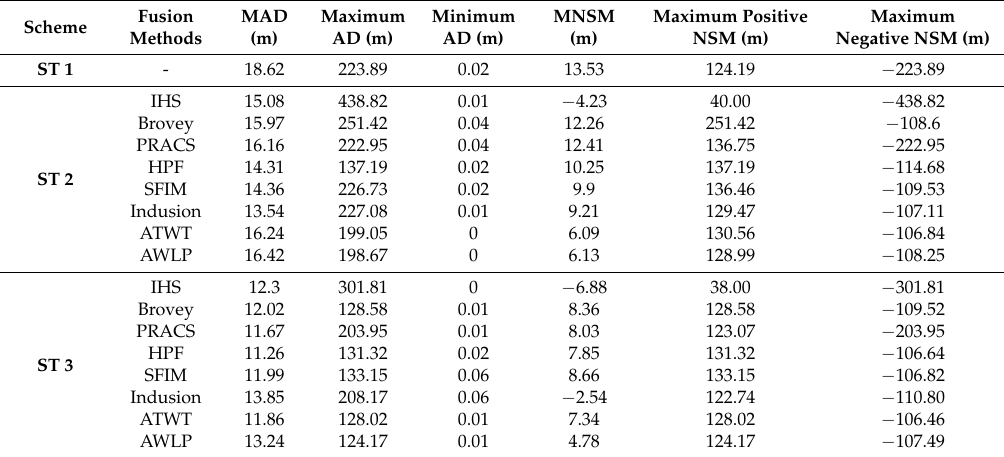
Table 3. Summary of coastline extraction accuracy for different strategies and pansharpening algorithms. (MAD is short for mean absolute difference; MNSM is short for mean net shoreline movement). Scheme